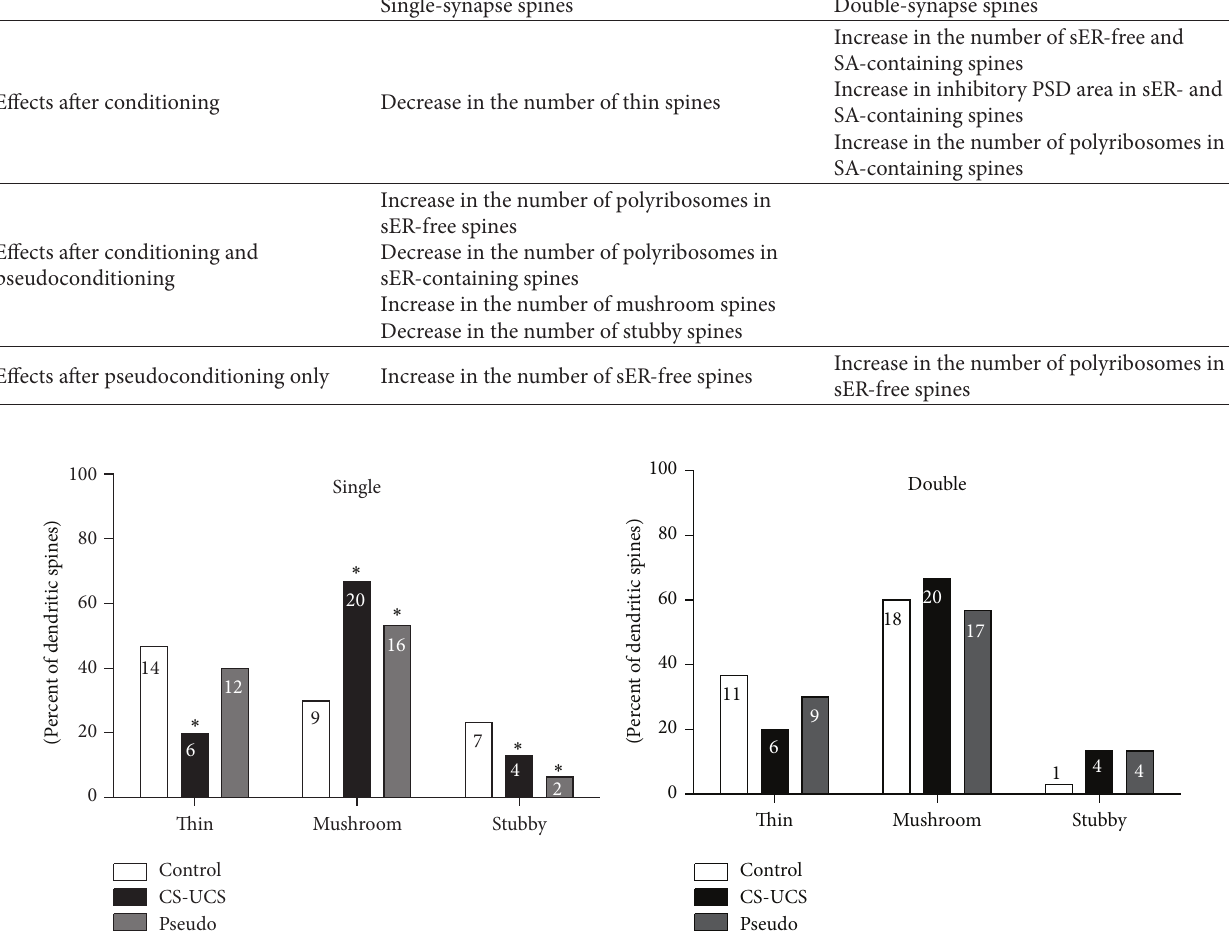
Table 1: Statistically significant effects of conditioning and pseudoconditioning on dendritic spines in the barrel cortex.